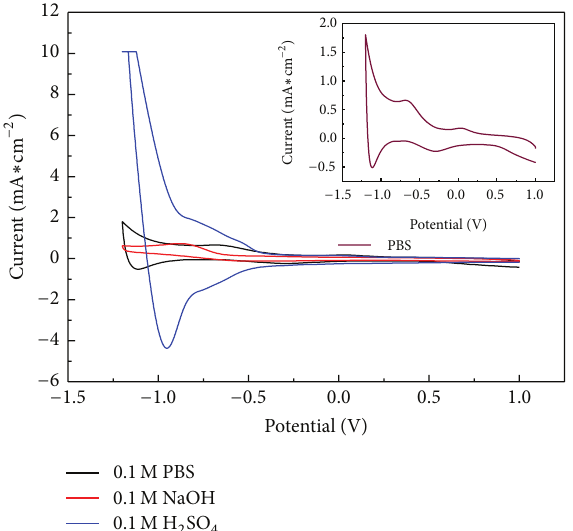
Figure 6: Calibration curve for the amperometric responses of the Ag-TiO 2 (500 ∘ C) nanotube electrode to glucose.